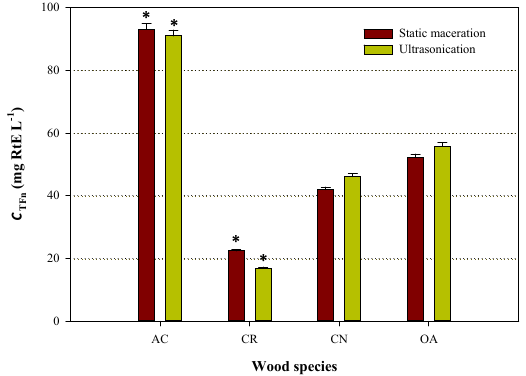
Figure 4. Comparative diagram showing C TFn of Tsipouro samples, aged with wooden chips under SM and US. Asterisk denotes statistically different values ( p <